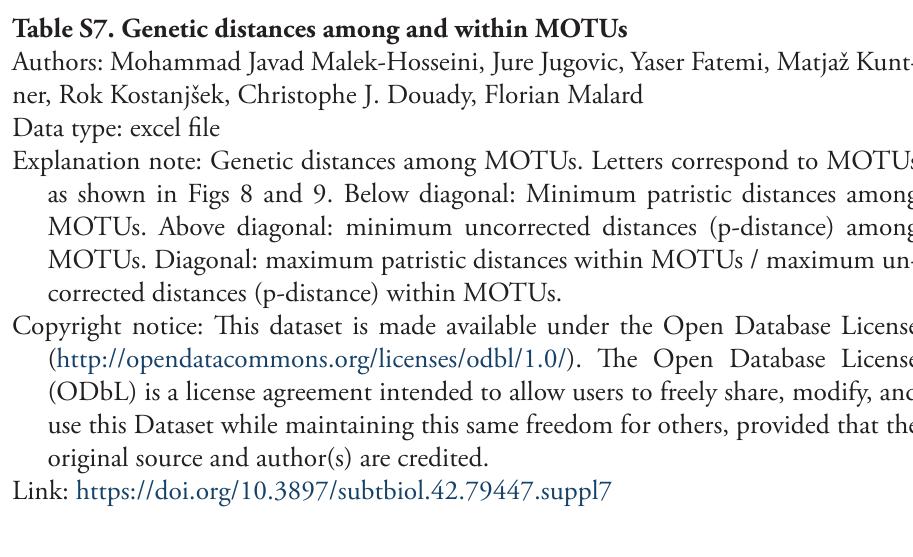
Table S7. Genetic distances among and within